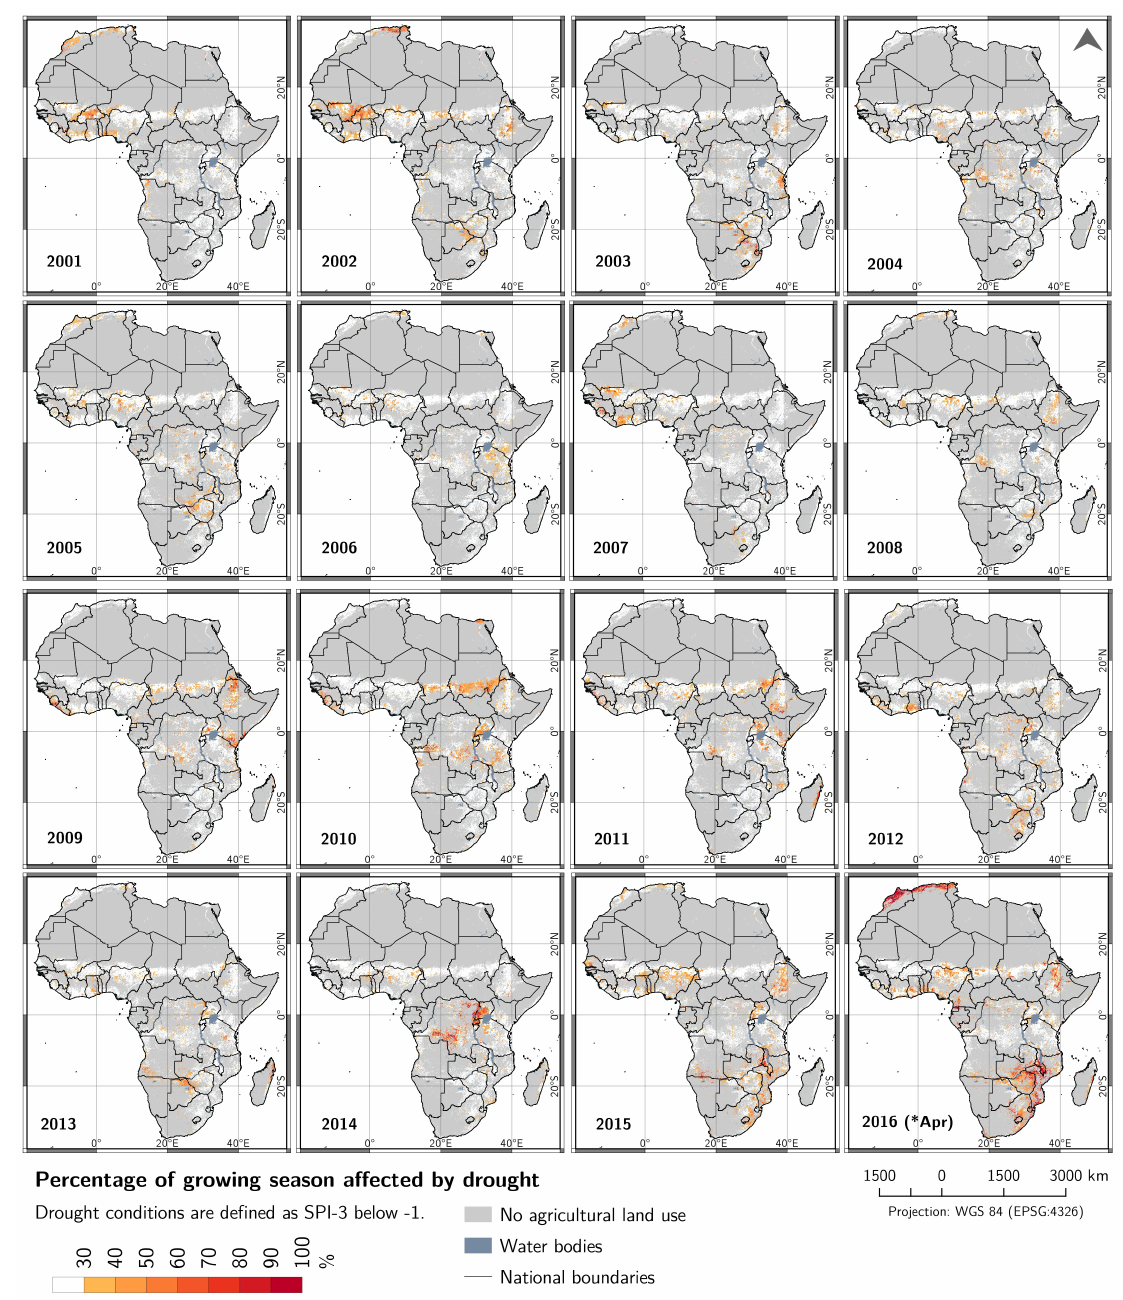
Figure 6. Relative duration of drought: Percentage of growing season affected by drought events (SPI-3 below − 1) from 2001 to 2016 (seasonal